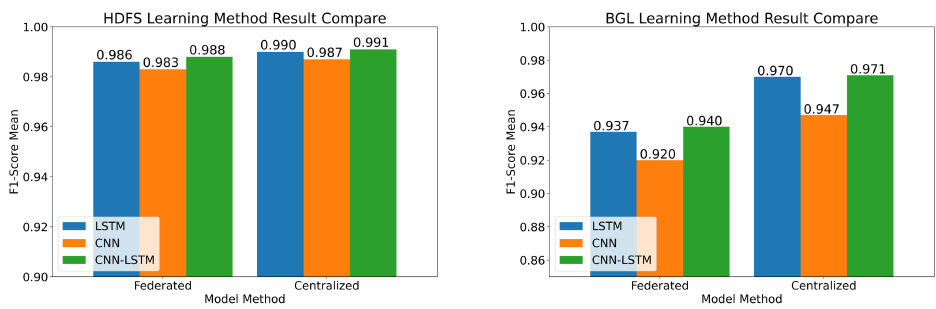
Figure 7. Performance comparison by deep learning models for